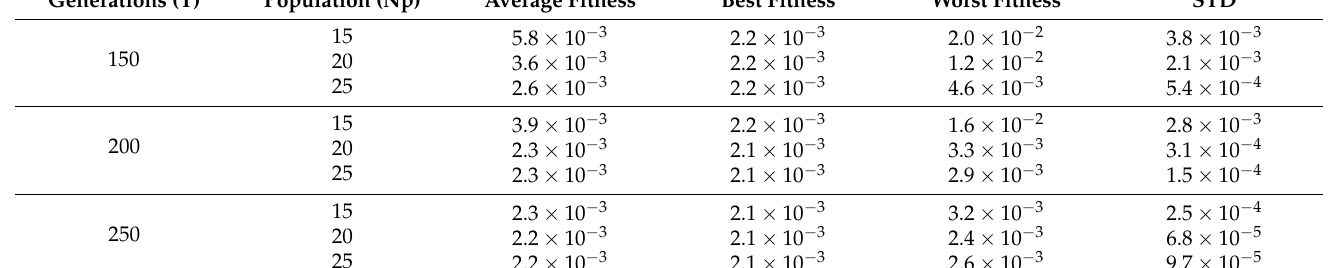
algorithm for noise variance = 0.01. In contrast, Figure 3d–f signifies the Best Fitness curves